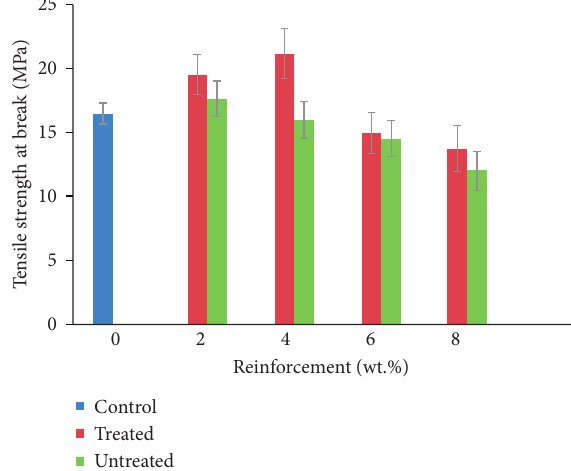
Figure 3: Variation in tensile strength of coir fibre and yam peel particulate polyethylene composite.